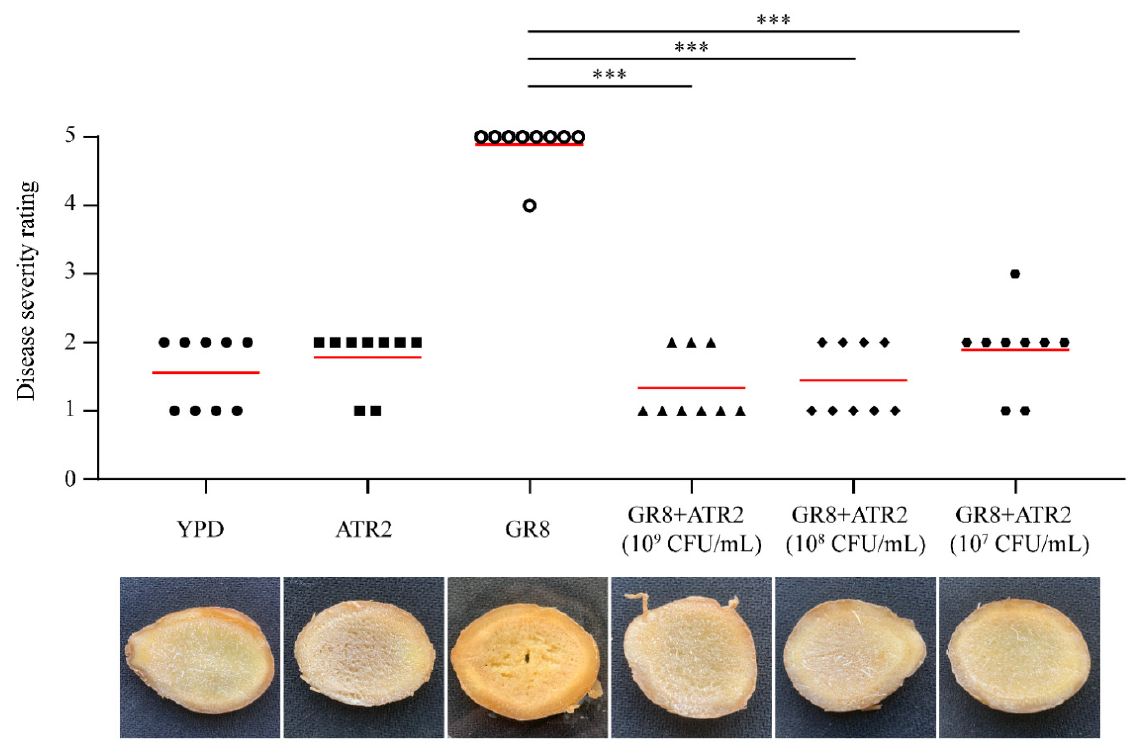
Figure 6. Biocontrol efficacy of B. velezensis ATR2 against ginger rhizome rot disease on ginger rhizome slices. The disease severity rating values were calculated using the unpaired two-tailed t -test with the GraphPad software (GraphPad Prism 8.4.0, San Diego, CA, USA) (*** p < 0.001). The marks represented the disease severity rating values of 9 inoculated ginger rhizome slices. The red lines in the plot area represented the average disease severity rating values.